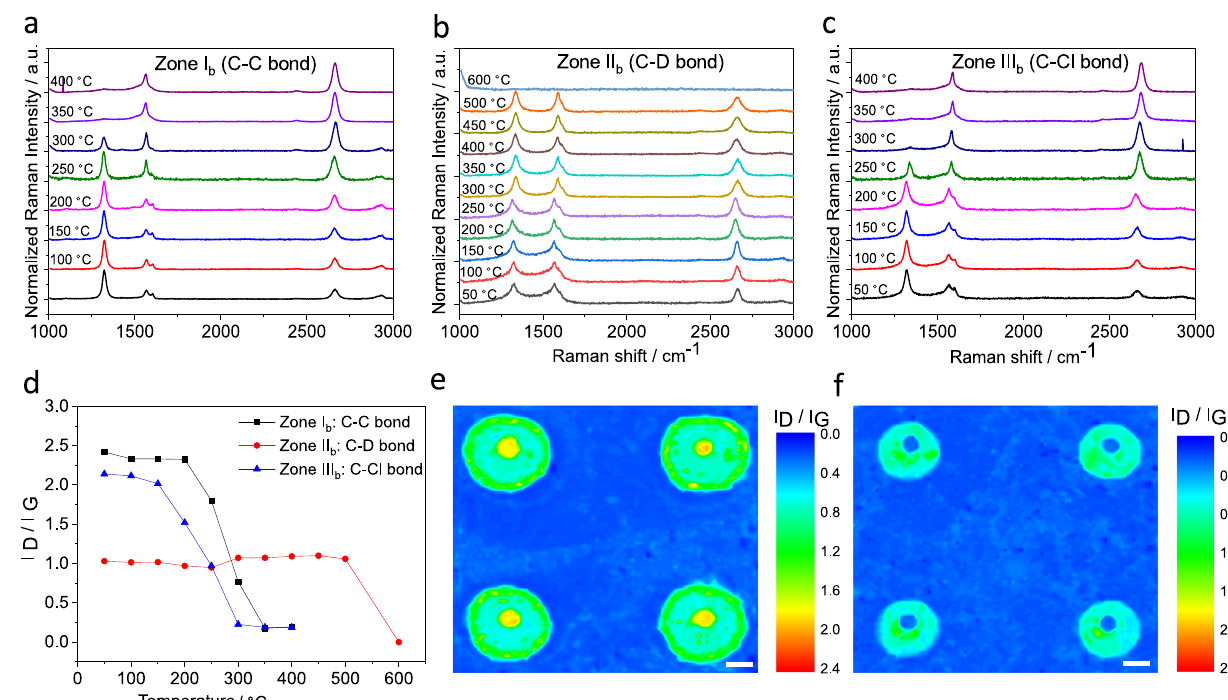
Fig. 4 Temperature-dependent Raman analyses. Temperature-dependent statistical Raman spectra of: a zone I b , b zone II b , and c zone III b . d Mean Raman I I D / G ratio extracted from the temperature-dependent Raman spectra of ( a , b , c ). Raman The variations in color from blue to red in ( e ) and ( f ) represent the change in I D / I G ratio from 0 to 2.4. The yellow circles, turquoise concentric rings, green concentric rings, and blue background in ( e ) denote I D / I G ratios are 1.8, 0.7,1, and 0, respectively. The turquoise hollow rings and blue background in ( f ) denote I D / I G ratios are 1 and 0, respectively. I D / I G : Raman D-band to G-band intensity ratio. Scale bar = 5 µ m.